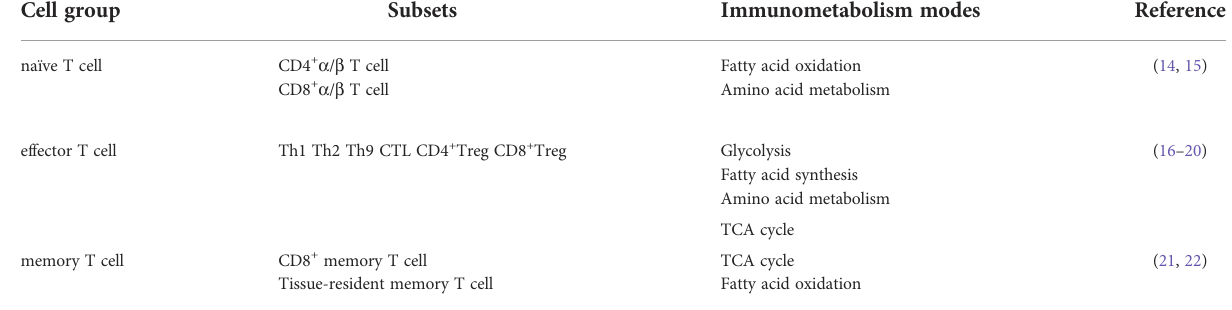
TABLE 1 Diverse T cell subset immunometabolism has distinct